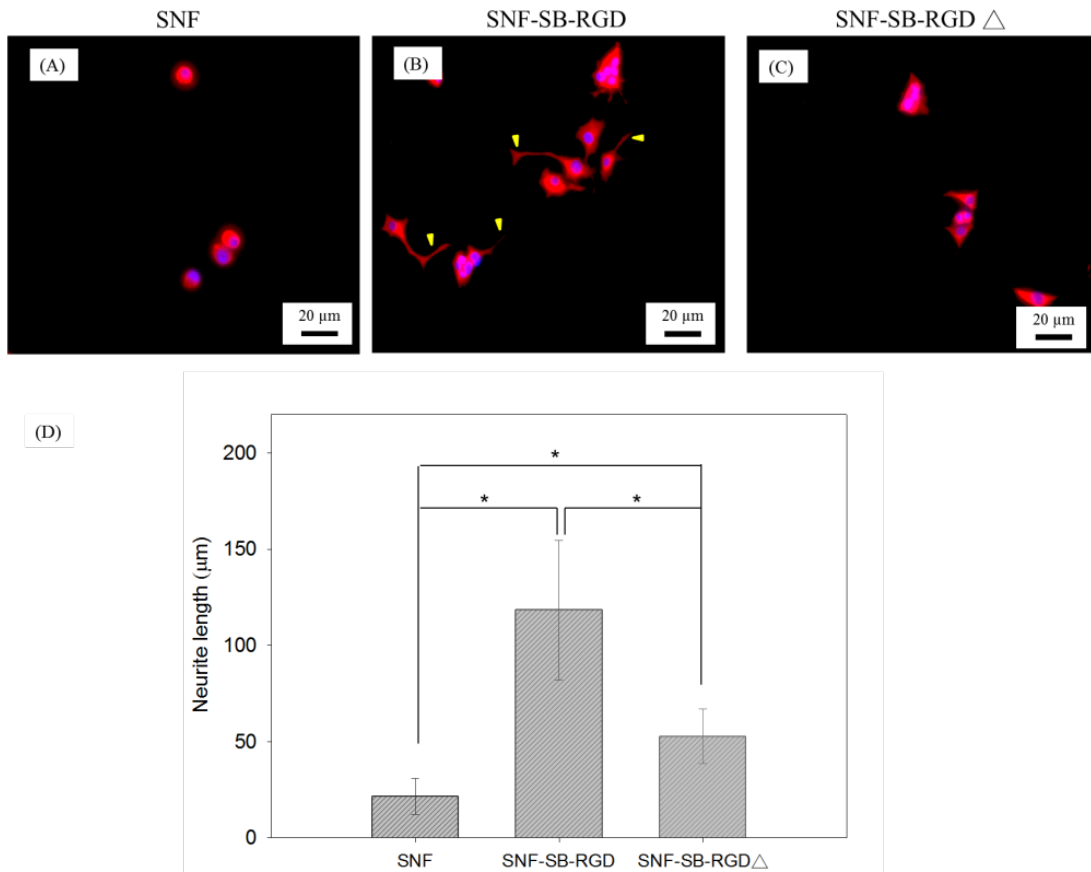
Figure 7. Fluorescence microscopy image of PC12 cell differentiation on ( A ) SNF, ( B ) SNF-SB-RGD, and ( C ) SNF-SB-RGD∆ substrates at Day 5. Neurite (indicated with arrowheads) was immunostained with MAP2 (red). ( D ) Bar graph comparing the neurite length of PC12 cells cultured on the as-prepared SNF substrates. The scale bars represent 20 μm. (n = 23, t -test, * p < 0.05).